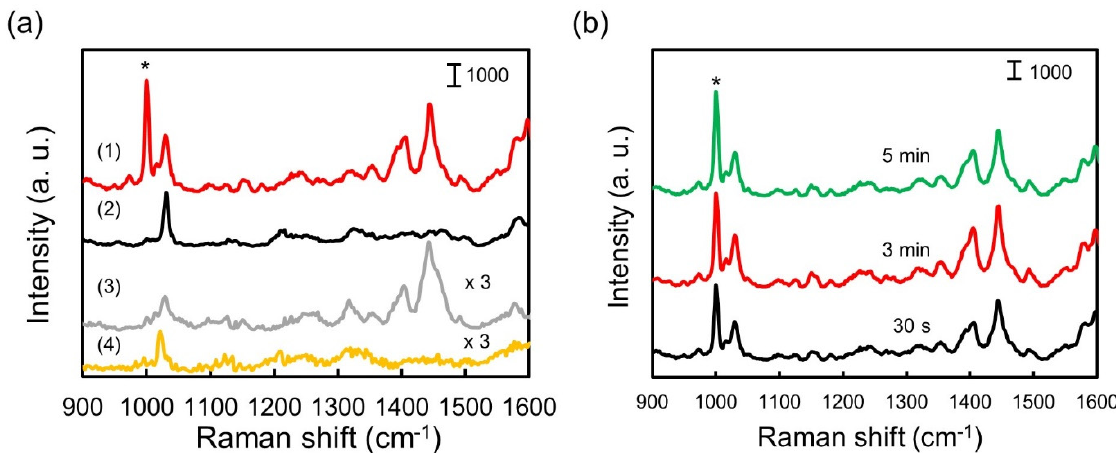
Figure 5. Effects of the sample pretreatment process on detection of drugs in urine. ( a ) SERS spectra of 0.1 ppm MC in urine measured (1) after and (2) before sample pretreatment and SERS spectra of blank urine samples measured (3) after and (4) before sample pretreatment. ( b ) SERS detection of 0.1 ppm MC in urine with different extraction time. The characteristic Raman peak of MC at 1000 cm − 1 is marked with “*”.